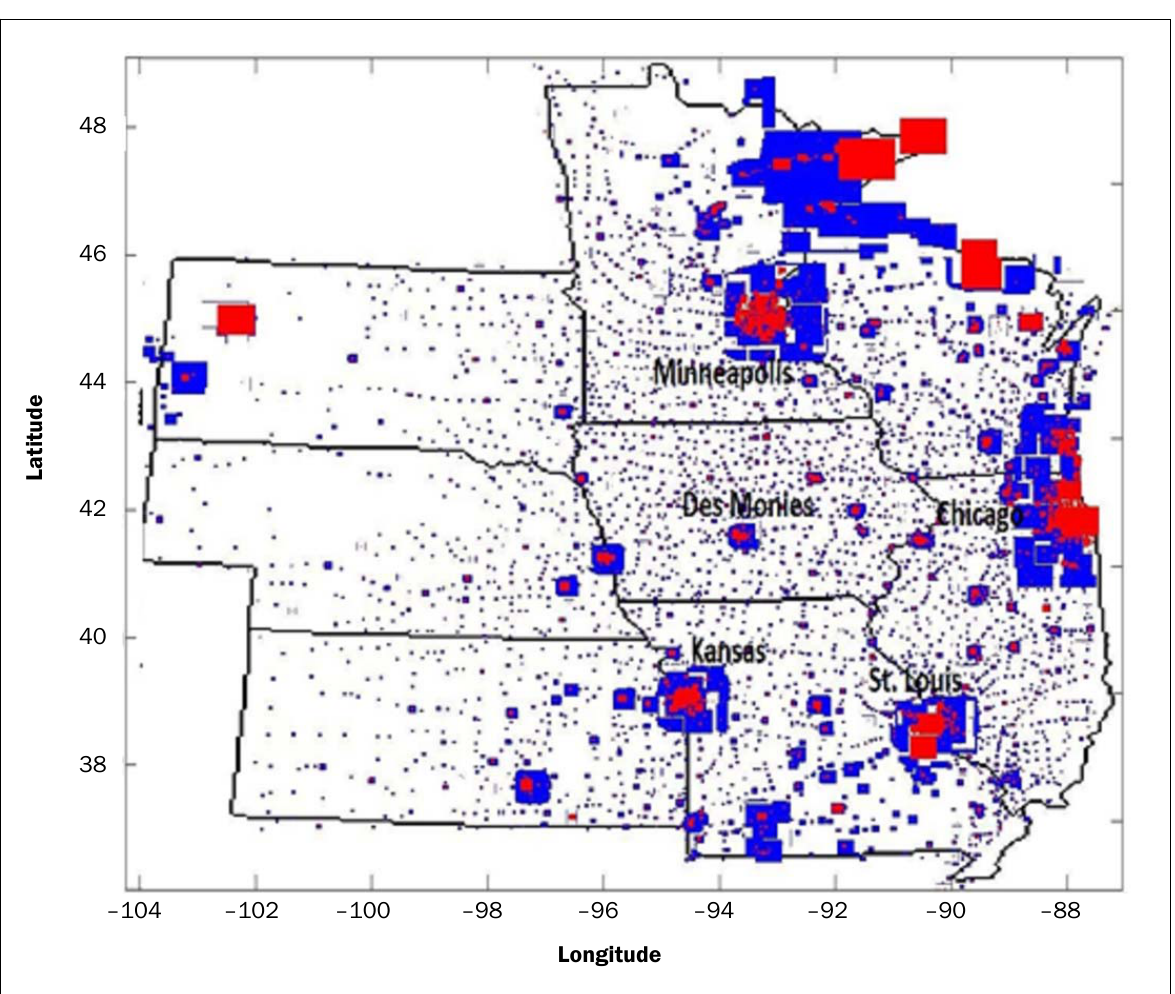
Figure 1. Foodshed Locations Identified Using Linear Optimization